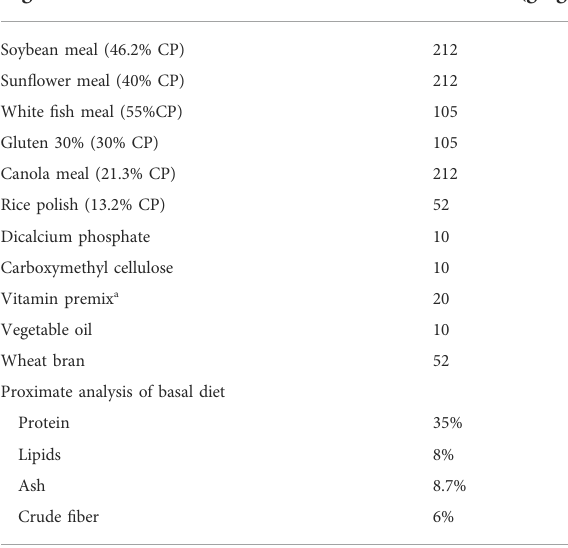
TABLE 1Recipe 35 percent proteinbasal dietfor Labeorohita (vitamin premix contains vitamins, amino acids, and minerals premix